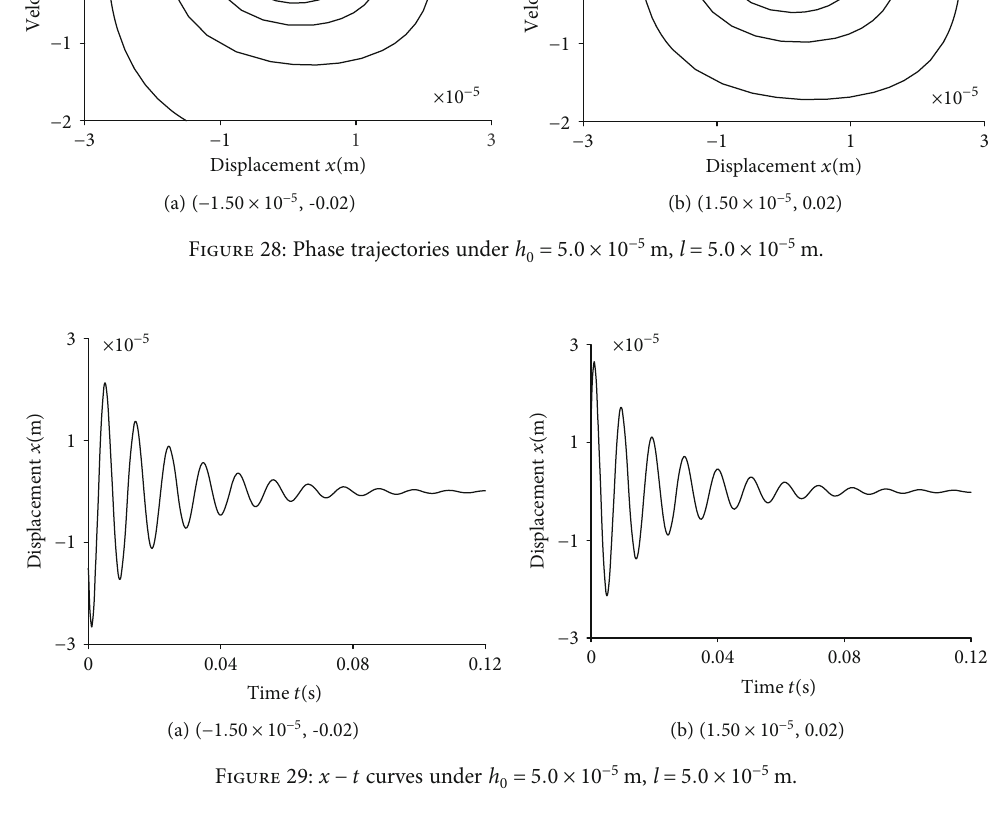
Figure 29: x − t curves under h